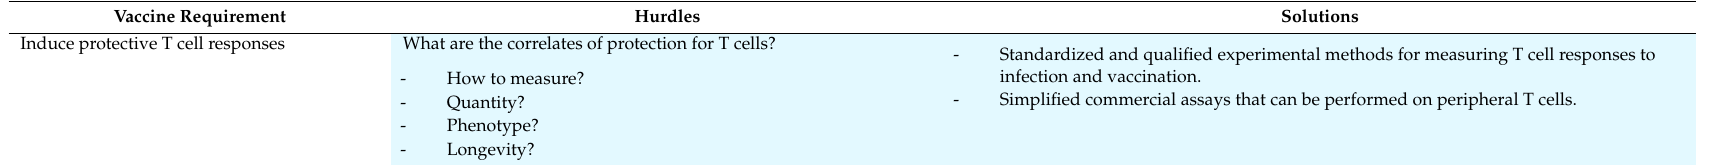
Consensus on an acceptable level of protection for T cell vaccines Providing population-wide coverage across diverse HLA profiles and ethnicities. Circumventing virus escape of T cell immunity. Establish local immunity at the site of infection Seeding durable, effective Trm memory populations in the lung and upper respiratory tract. Combining long-lasting broadly-reactive T and B cell immunity.